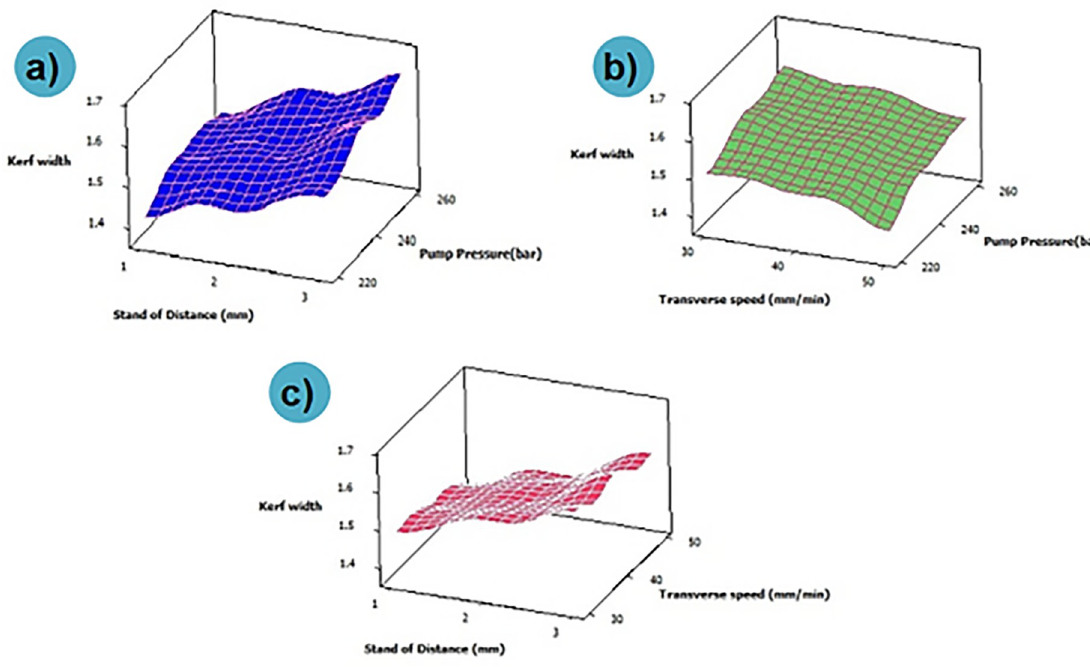
Fig 6. Influence of AWJM parameters on kerf width for PMC without filler.